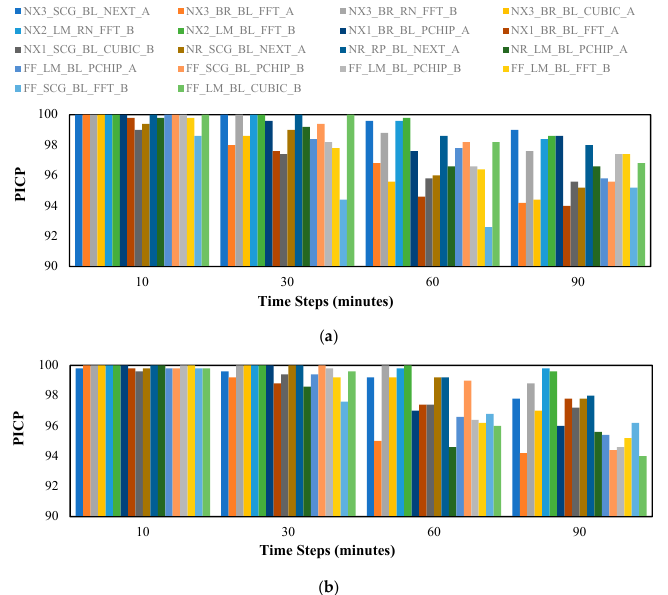
Figure 8. The 18 best ‐ performing variations in terms of PICP for ( a ) wind speed prediction, and ( b ) wind direction prediction, at different time horizon (i.e., 10, 30, 60, and 90 min). Note that 500 samples were used; each of which is a 10 min interval. This results in a total of ~83 h.